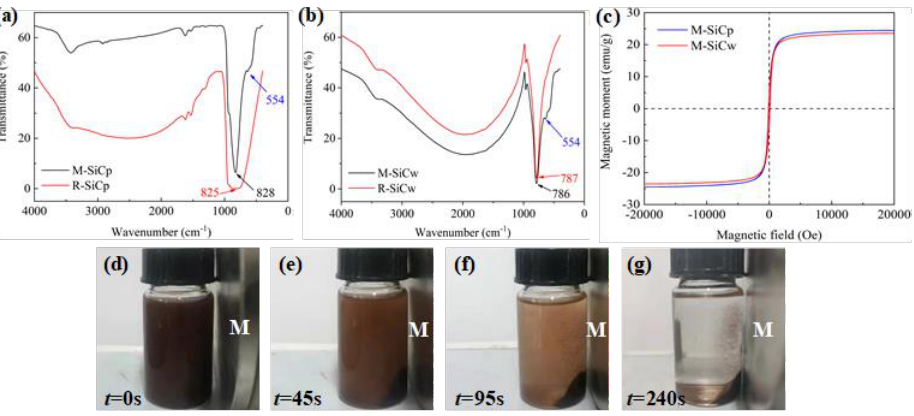
Figure 6. FTIR spectra and magnetic response phenomenon. ( a ) FTIR spectra of R-SiCp and M-SiCp; ( b ) FTIR spectra of R-SiCw and M-SiCw; ( c ) magnetic hysteresis loops of M-SiC; ( d – g ) magnetic response phenomenon of M-SiC in absolute ethanol (the letter M in the figure stands for perma- nent